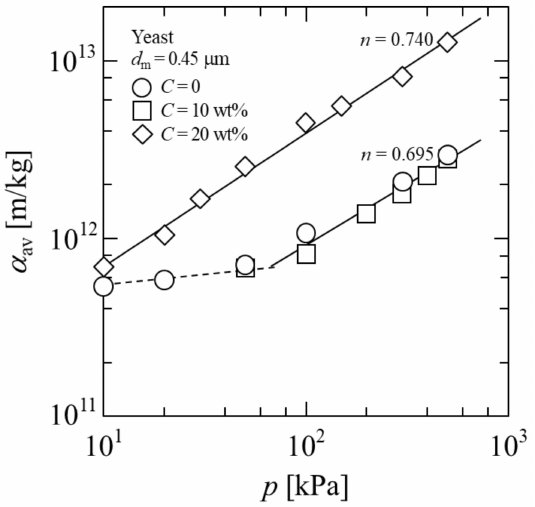
Figure 9. Logarithmic plot of average specific cake resistance against applied